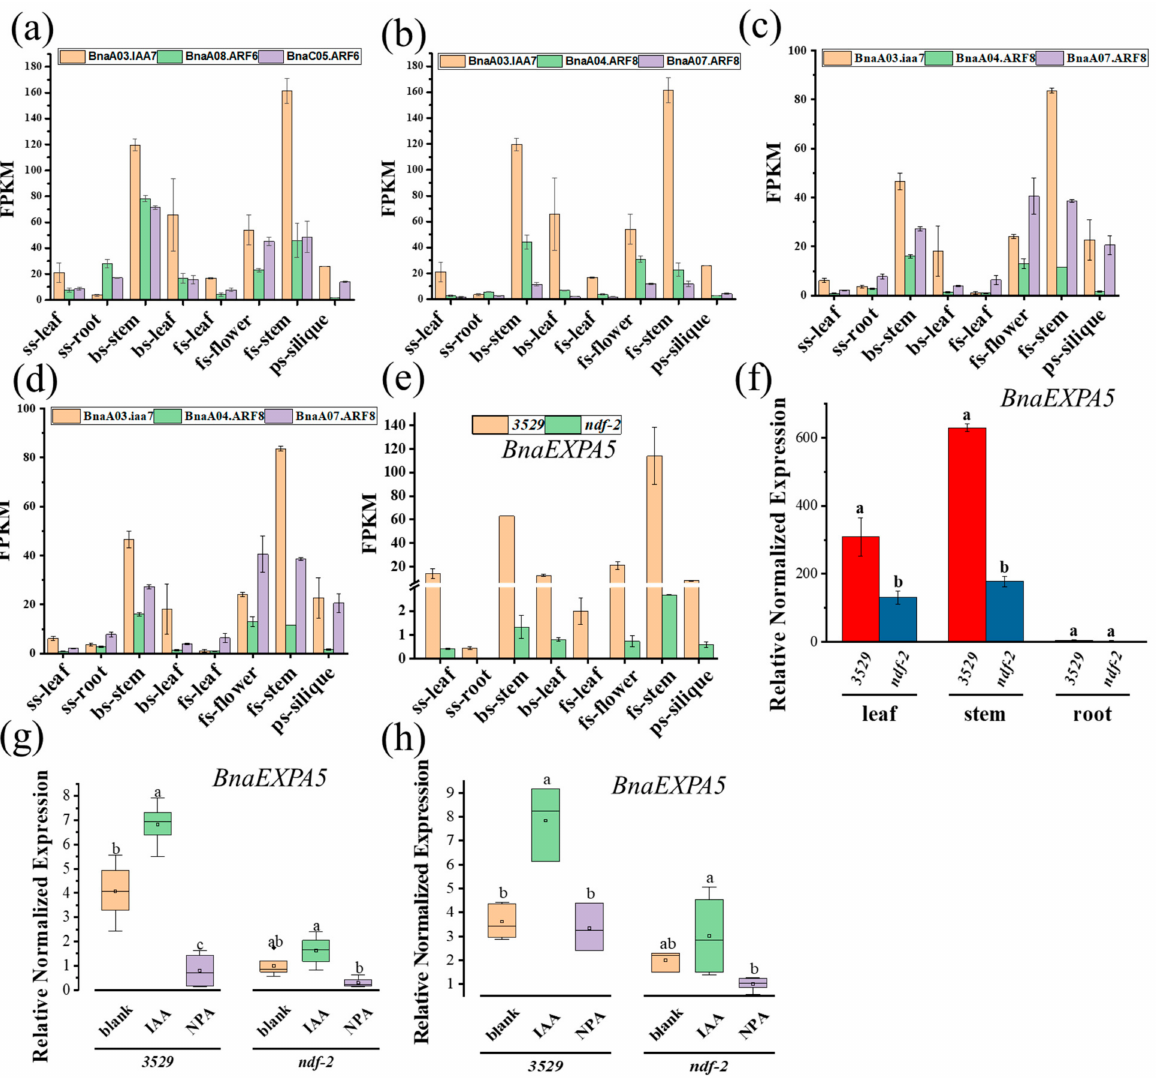
Figure 4. Expression analysis of auxin-related genes in 3529 and ndf-2 mutants. ( a – d ) The expressions of BnaARF6 and BnaARF8 were compared with that of BnaA03.IAA7 in 3529 ( a , b ) and ndf-2 ( c , d ). ( e , f ) The differential expression of BnaEXPA5 gene between 3529 and ndf-2 was observed in RNA-seq ( e ) and qPCR ( f ) results. ( g , h ) The response of BnaEXPA5 transcription level to IAA or NPA treatment was found in stem ( g ) and leaf ( h ). In ( a – e ), the X -axis represents the plant tissues of different periods. Values are mean ± SD ( n = 2 in ( a – e ), n = 3 in ( f – h ). The boxplots show the median (horizontal line), 25% and 75% (down and up edge of the box), minimum and maximum (down and up edge of the whiskers), average (square in the box), and outliers (black spots) ( n = 4 to 6). Different lowercase letters denote significant differences among the genotypes ( f ) and conditions ( g , h ) ( p < 0.05, one-way ANOVA followed by Tukey’s test for multiple comparisons). Values are the means ± SD ( n =